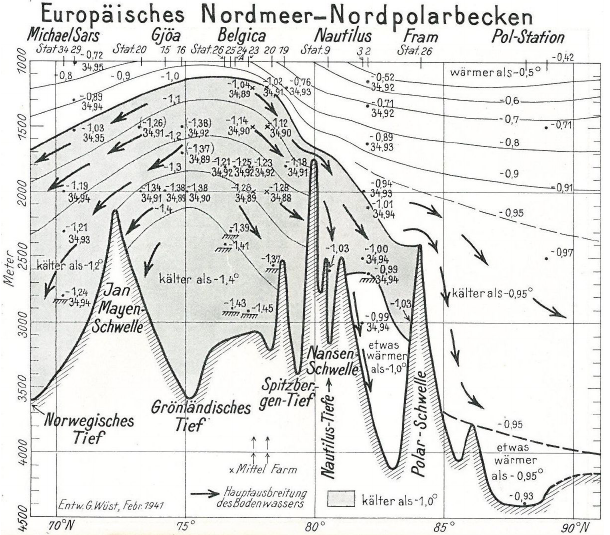
Fig. 4. Bathymetry of the Arctic Ocean (IBCAO) (Jakobsson et al., 2008), map from Rudels et al. (2011). AB (Amerasian Basin), EB (Eurasian Basin), BIT (Bear Island Trough), VC, (Victoria Chan- nel), FJL (Franz Josef Land), SAT (St. Anna trough), VS (Vilk- iltskiy Strait), YM (Yermak Plateau), MJP (Morris Jesup Plateau), GFZ (Greenland Fracture Zone), JMFZ (Jan Mayen Fracture